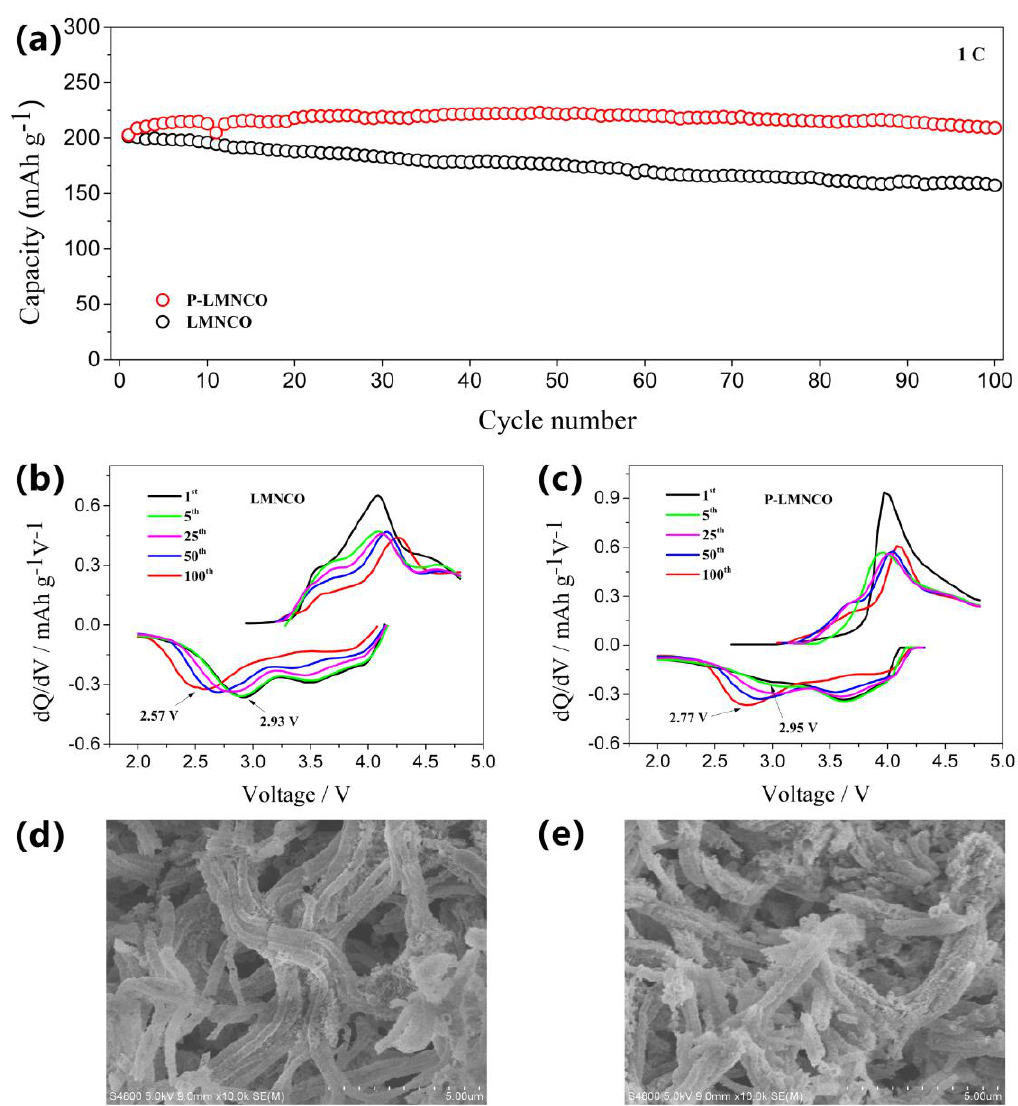
Figure 6. ( a ) Cyclic stability performance. The differential capacity curves (dQ/dV vs. V) of ( b ) LMNCO and ( c ) P-LMNCO; FE-SEM images of ( d ) LMNCO and ( e ) P-LMNCO.